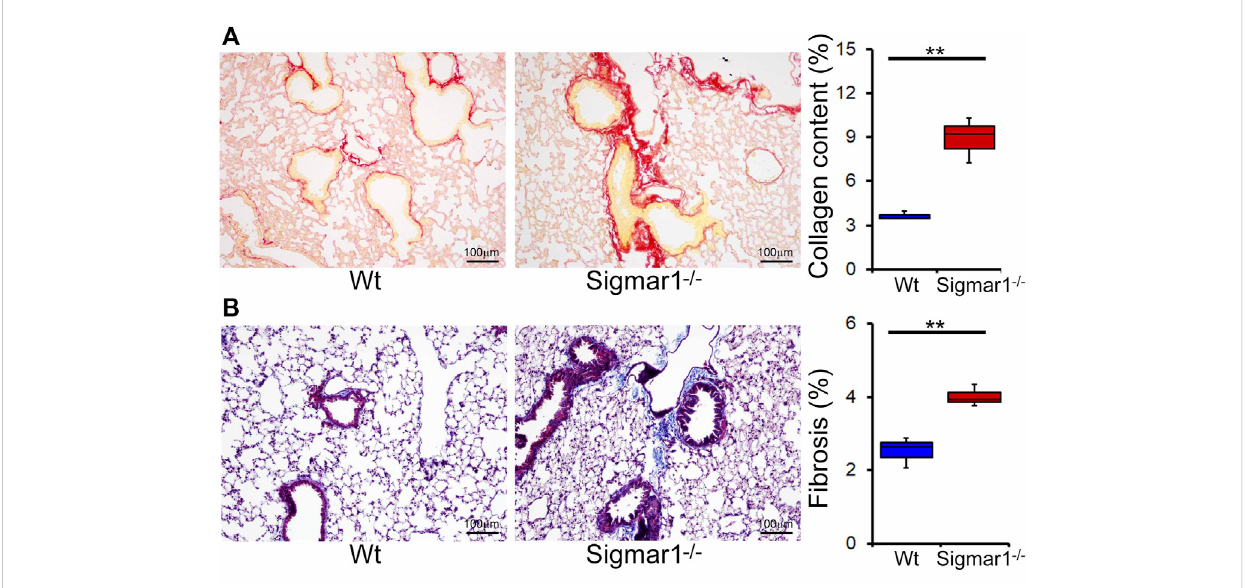
FIGURE 3 Increased collagen deposition and pulmonary fi brosis in aged Sigmar1 − / − mouse lung. (A) Picrosirius Red staining of paraf fi n fi xed lung histological tissuesectionsshowedincreasedcollagendeposition(red)intheagedSigmar1 − / − mouselungscomparedtoagematchlittermateWtmouselungs(n=3). (B) Masson ’ s Trichrome staining of paraf fi n fi xed lung histological tissue sections showed increased fi brotic remodeling in Sigmar1 − / − mouse lungs compared to age match littermate Wtmouse lungs (n = 3 per group). Scale bars:100 µm. The Kruskal – Wallis test determined p values, and p < 0.05 was considered statistically signi fi cant.